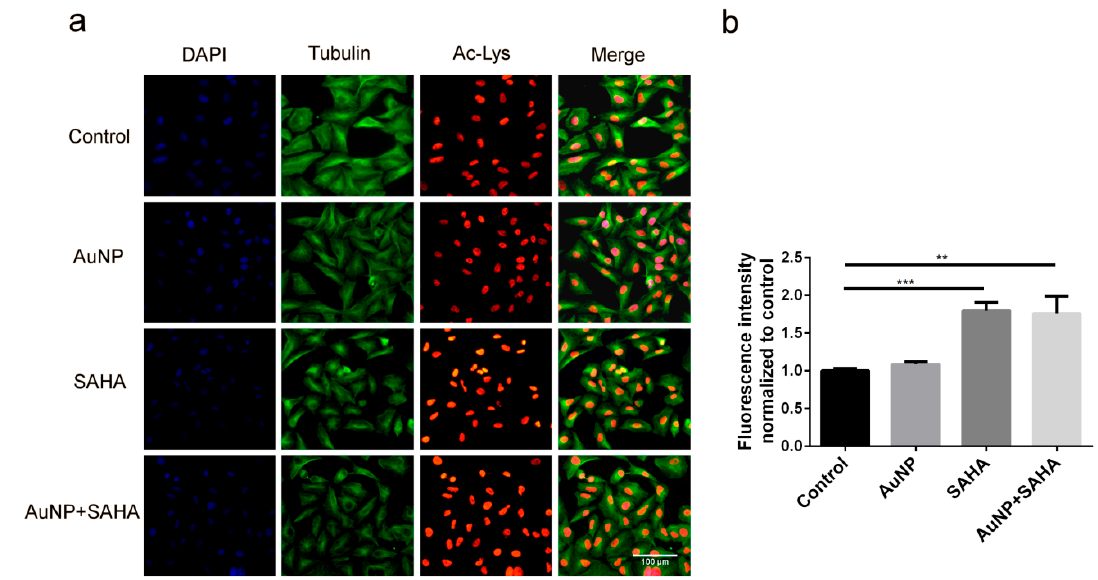
Figure 3. The presence of AuNPs does not affect the histone deacetylase inhibitor activity of SAHA. ( a ) Increased level of acetylated-lysine was observed in the SAHA- and AuNP + SAHA-treated A549 cells, visualized by fluorescence microscopy. ( b ) The fluorescence intensity of acetylated lysine was significantly higher in SAHA- and in AuNP + SAHA-treated samples, quantified by plate reader measurements. (** p value = 0.0043; *** p value = 0.0003; Unpaired t -test).